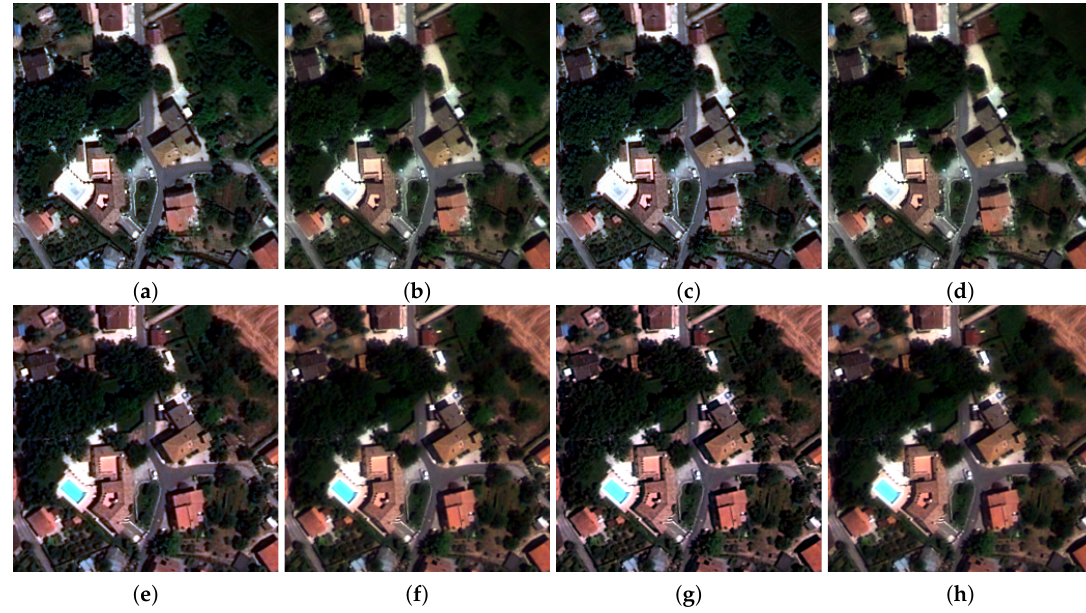
Figure 4. True color compositions of 256 × 256 fragments of the GeoEye-1 pansharpened images acquired ( a – d ) on 27 May 2010 and ( e – h ) on 13 July 2010. ( a , e ) component substitution without path-radiance correction (CSw/oPRC); ( b , f ) CSw/PRC; ( c , g ) multiresolution analysis without PRC (MRAw/oPRC); ( d , h ) MRAw/PRC.